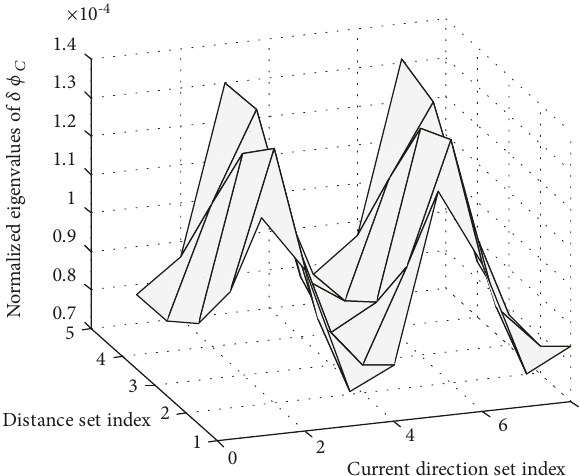
Figure 15: Normalized eigenvalues of the estimated current direction error under di ff erent current direction and distance